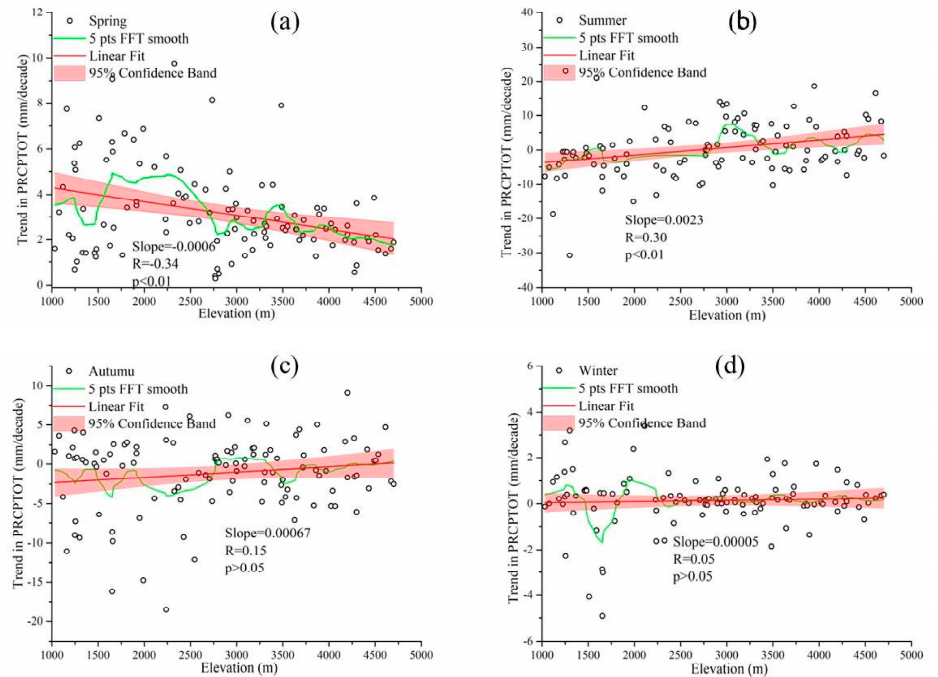
Figure 7. Scatter plots of trends (mm/decade) by elevation for seasonal total precipitation (( a ) spring; ( b ) summer; ( c ) autumn; ( d ) winter) in the TP and TPS during 1971–2017.